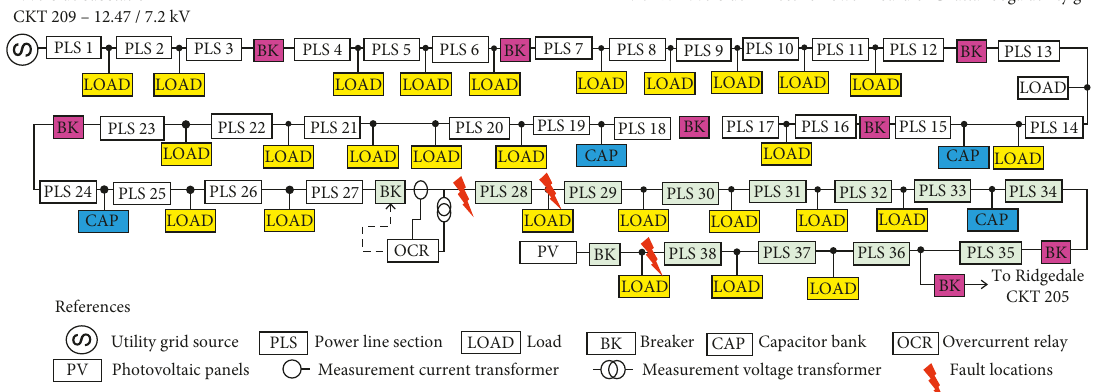
Figure 3: Single-line diagram of 12.47 kV Riverside—EPB of Chattanooga utility grid.